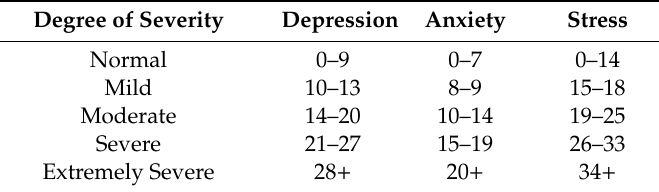
Table 2. Severity labels of depression, anxiety, and